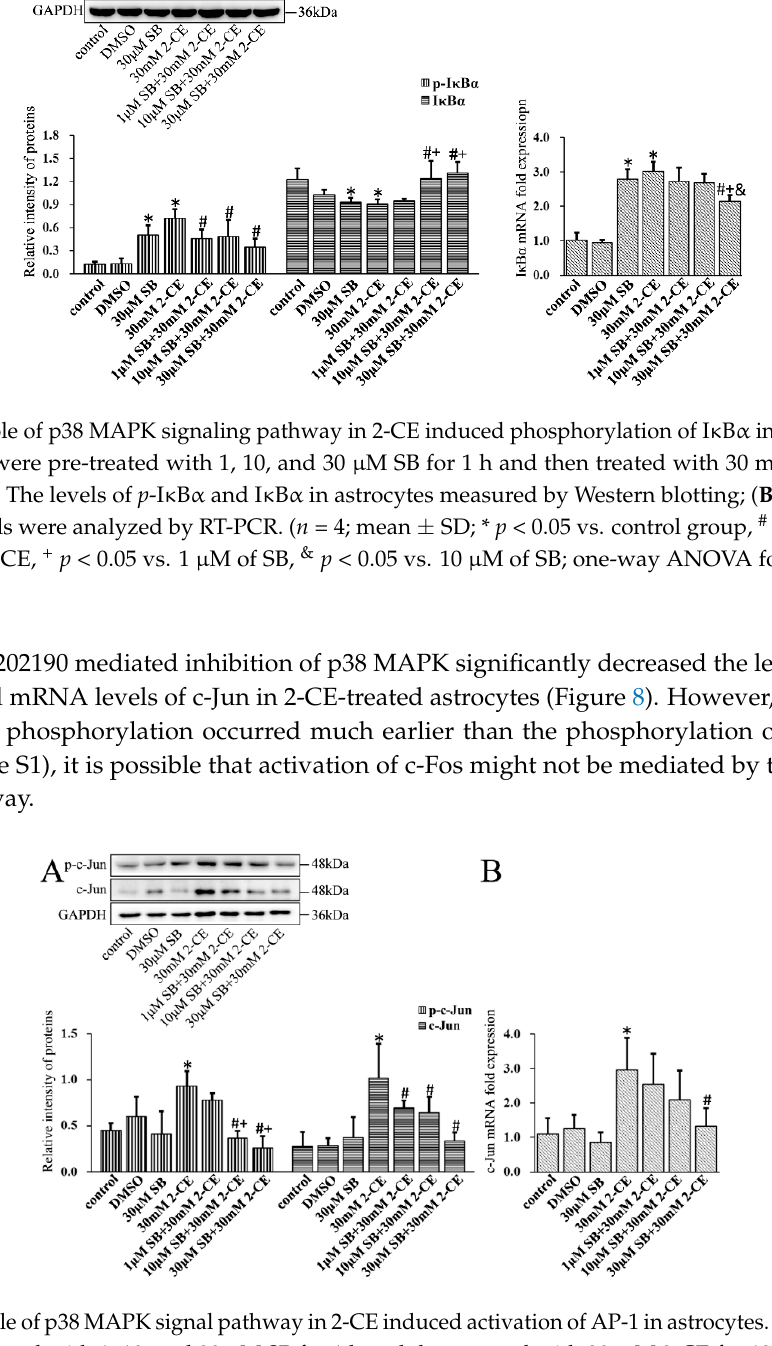
Figure 8. Role of p38 MAPK signal pathway in 2-CE induced activation of AP-1 in astrocytes. Astrocytes were pre-treated with 1, 10, and 30 µM SB for 1 h and then treated with 30 mM 2-CE for 12 h. ( A ) The levels of p-c-Jun and c-Jun in astrocytes measured by Western blotting; ( B ) The c-Jun mRNA levels analyzed by RT-PCR. ( n = 4; mean ± SD; * p < 0.05 vs. control group, # p < 0.05 vs. 30 mM of 2-CE, + p < 0.05 vs. 1 µM of SB; one-way ANOVA followed by SNK tests.).